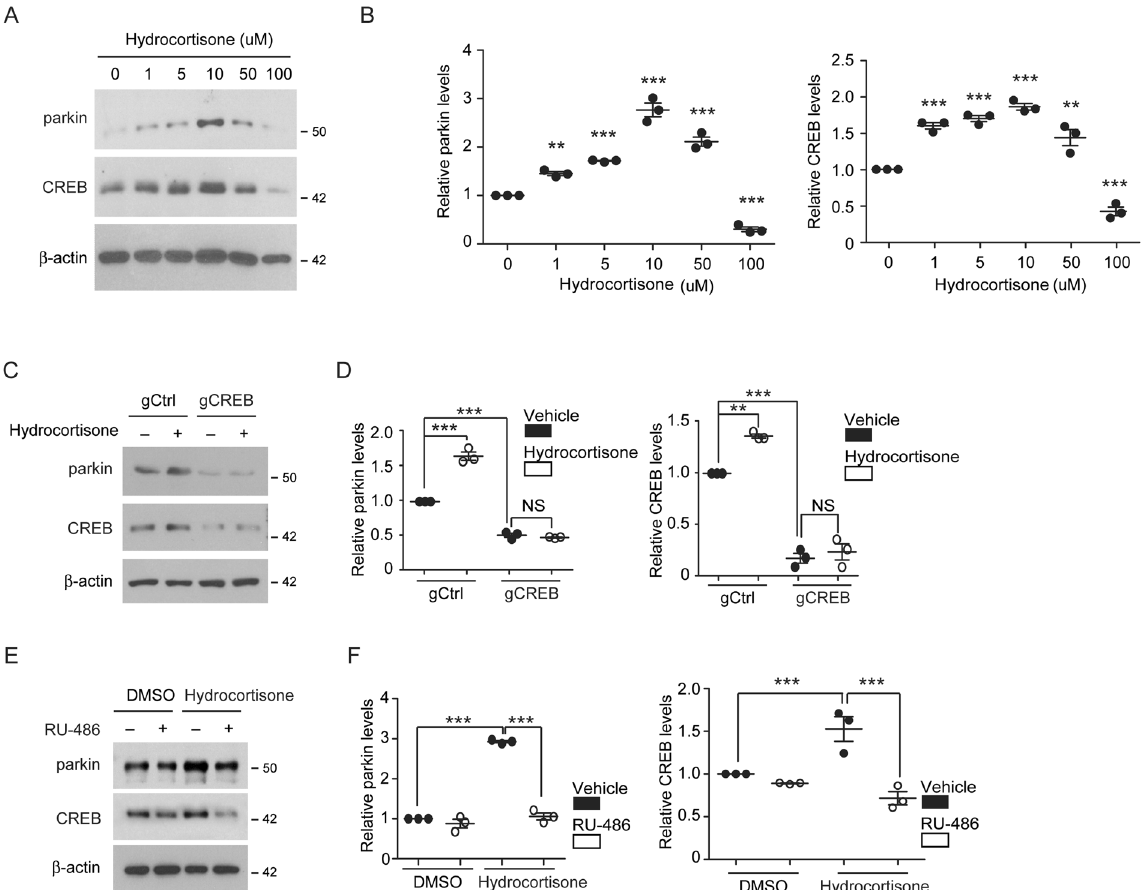
Figure 4. CREB-mediated parkin expression induced by hydrocortisone. ( A ) Expression of parkin and CREB in SH-SY5Y cells in response to treatment of hydrocortisone in increasing dose determined by western blot. ( B ) Relative levels of parkin or CREB were normalized to that of β -actin ( n = 3). ( C ) Western blot analysis of parkin and CREB expression in SH-SY5Y cells transiently transfected with gRNA specific for CREB or control gRNA followed by hydrocortisone treatment. ( D ) Relative parkin or CREB levels were normalized to that of β -actin in the indicated experimental groups ( n = 3). ( E ) Western blot analysis of parkin and CREB levels in SH-SY5Y cells. Cells were treated with glucocorticoid receptor antagonist RU-488 followed by hydrocortisone treatment to examine parkin and CREB induction. ( F ) Relative parkin and CREB induction in response to hydrocortisone treatment in SH-SY5Y cells pretreated with RU-486 (mifepristone) or vehicle control ( n = 3 per group). Quantified data are expressed as mean ± s.e.m. ** P < 0.01 and *** P < 0.001, ANOVA test followed by Tukey post hoc analysis ( B , F , and parkin quantification in Fig. 4D) or nonparametric Kruskal-Wallis ANOVA test (CREB quantification in Fig. 4D). Full blots (for cropped images in A , C , E ) are presented in Figure